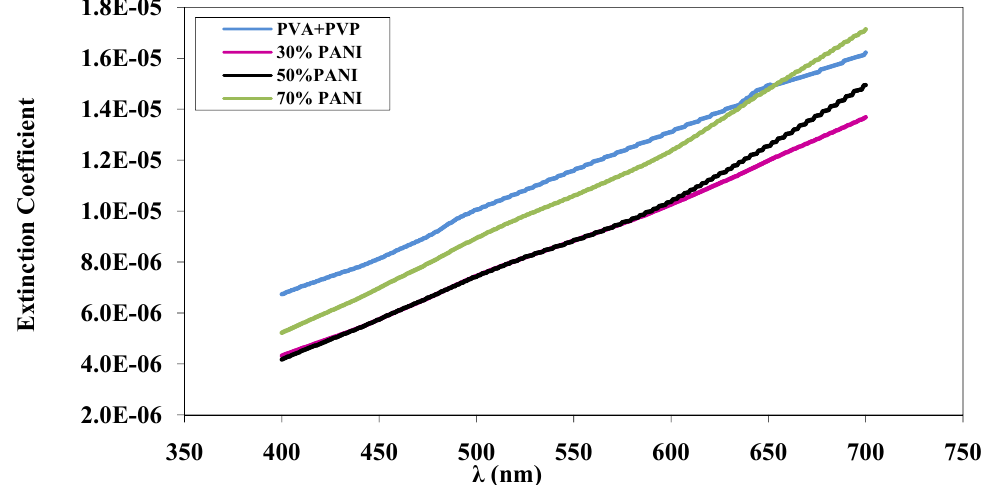
Fig.6: The extinction coefficient (K)vs. wave length (nm) for (PVA-PVP) +PANI blends